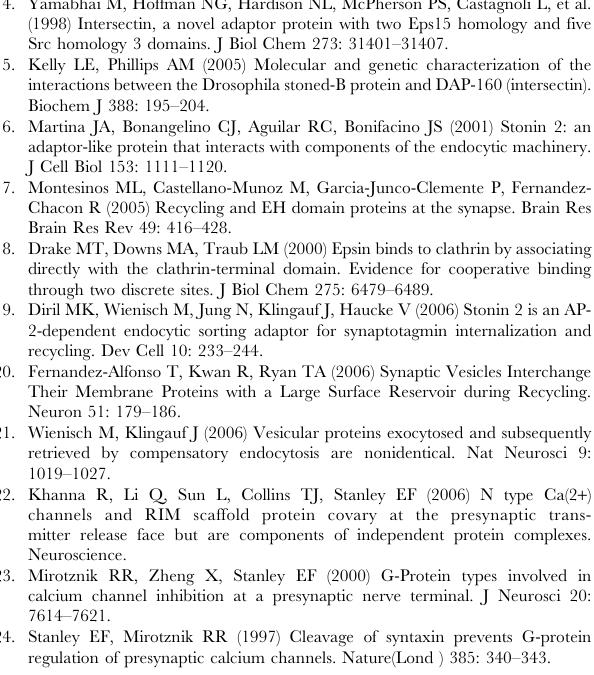
protein (as indicated on y-axis). The rows show the FR for the protein B or vice versa (as labeled, Fig. S1C). Note the similar FR values in either direction, as would be expected if these reflect the same molecular interactions. Figure S2 Fractional recovery (FR) series congruence analysis. Each plot compares two FR sequences for congruence and, hence, origin from the same protein complex. The filled symbols show the set of mean 6 SE FR sequence for a test IP-protein (replotted from Fig. 2A-E). The open symbols show the FR sequence for a second IP-protein adjusted for the differences in the FR values of the two IP-proteins. Note that most of the transformed IP-protein pre- dictions are within 2SE of the test protein, supporting their origin from the same protein complex. The test IP-protein/transformed IP-protein pairs are: A. AP180/H-clathrin, B. AP180/synapto- tagmin, C. L-clathrin/synaptotagmin, and D. S-intersectin/